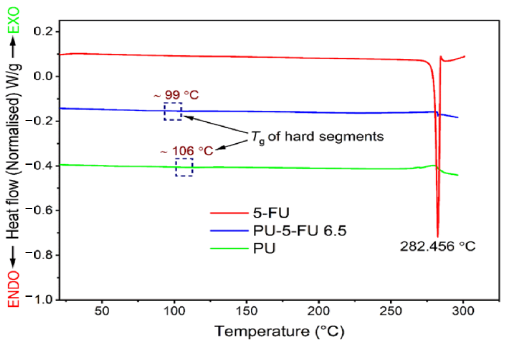
Figure 6. Differential scanning calorimetry thermograms (first heating cycle) recorded at a heating rate of 10 °C/min for pure 5FU, and PU and PU 5FU films. The rectangular regions show the hard- segment glass transition temperatures at ~ 106 and ~ 99 °C for the PU and PU 5FU films, respectively. TGA was performed to investigate the thermal stability of 5FU within the PU matrix (Figure 7). The thermogram and corresponding derivative weight loss (DTG) curve for pure 5FU implies that the onset of degradation occurs at ~200 ◦ C with a peak maxima at ~293 ◦ C [69,77]. For the PU film, the decomposition onset temperature and peak maxima were observed at ~282 ◦ C and 335 ◦ C, respectively [72,78]. In contrast, the PU 5FU film displayed a slight weight decrease (~6.6%) between 200 and 293 ◦ C corresponding to decomposition of 5FU, followed by decomposition of the PU matrix. Despite slight overlap in the degradation events, the degradation of 5FU within the PU matrix based on weight loss correlates well with the original loading of the PU coating. Nevertheless, these results indicate that there was no notable change in the thermal stability of the 5FU due to inclusion in the PU polymer matrix.